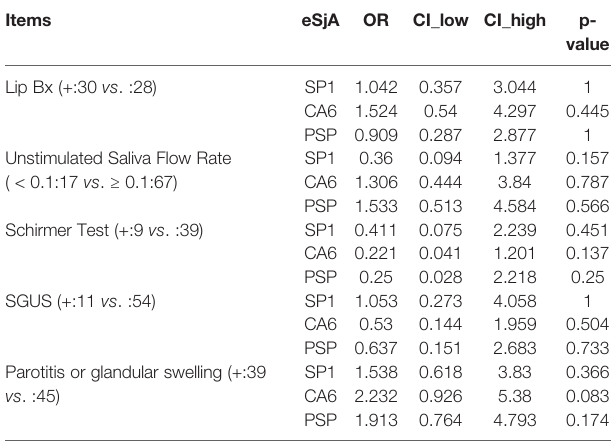
TABLE 5 | Association between diagnostic/glandular items and eSjA in SSA- negative